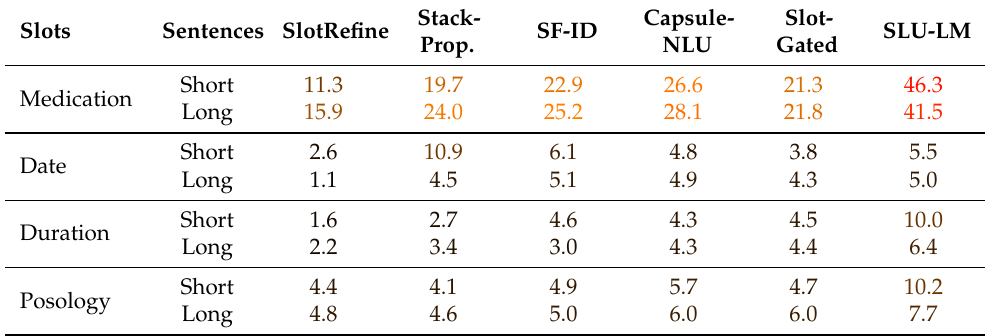
Table 8. Errors in slot tagging for long slots (in %).